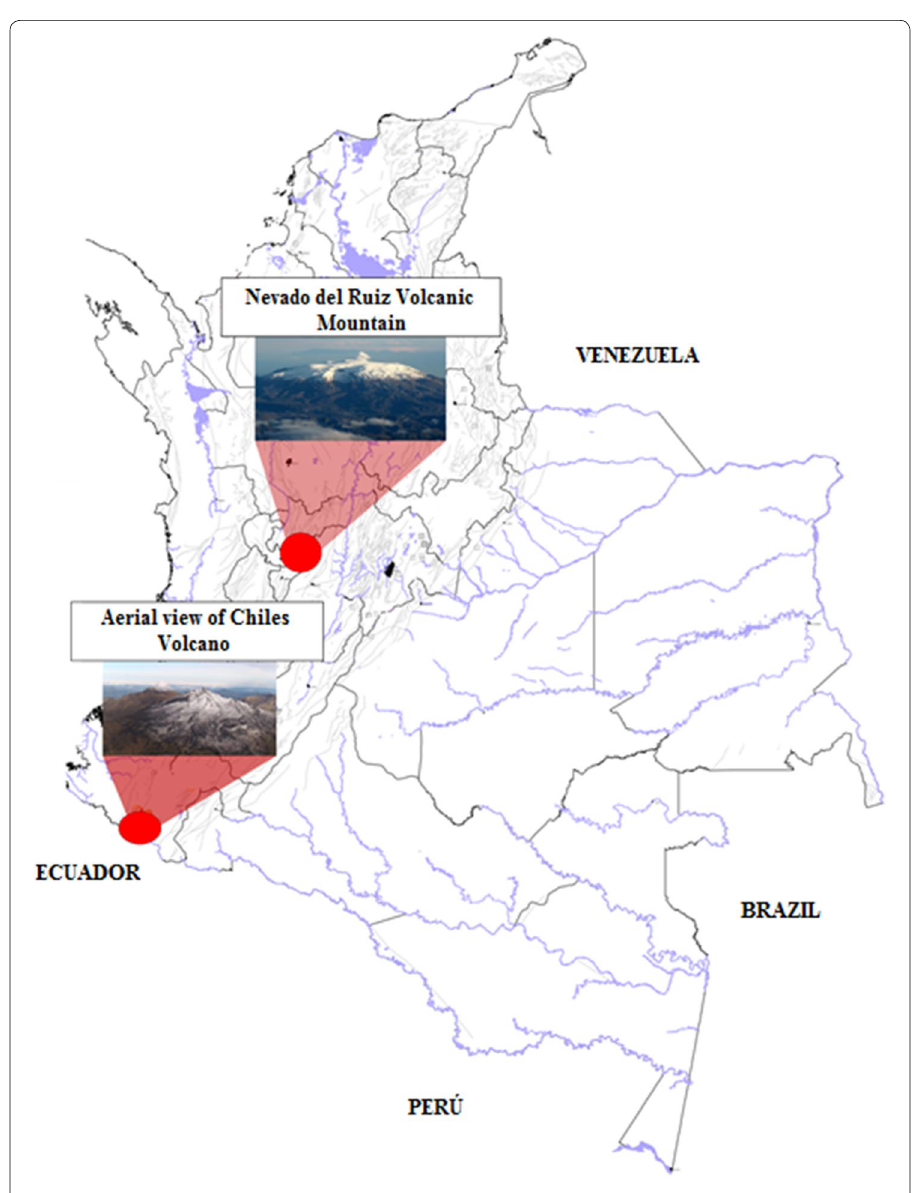
Fig. 6 Aerial view of Chiles Volcano and Nevado del Ruiz Volcanic Mountain (Reproduced with permission from SENCAR 2015; IG-EPN 2015; Vargas et al.